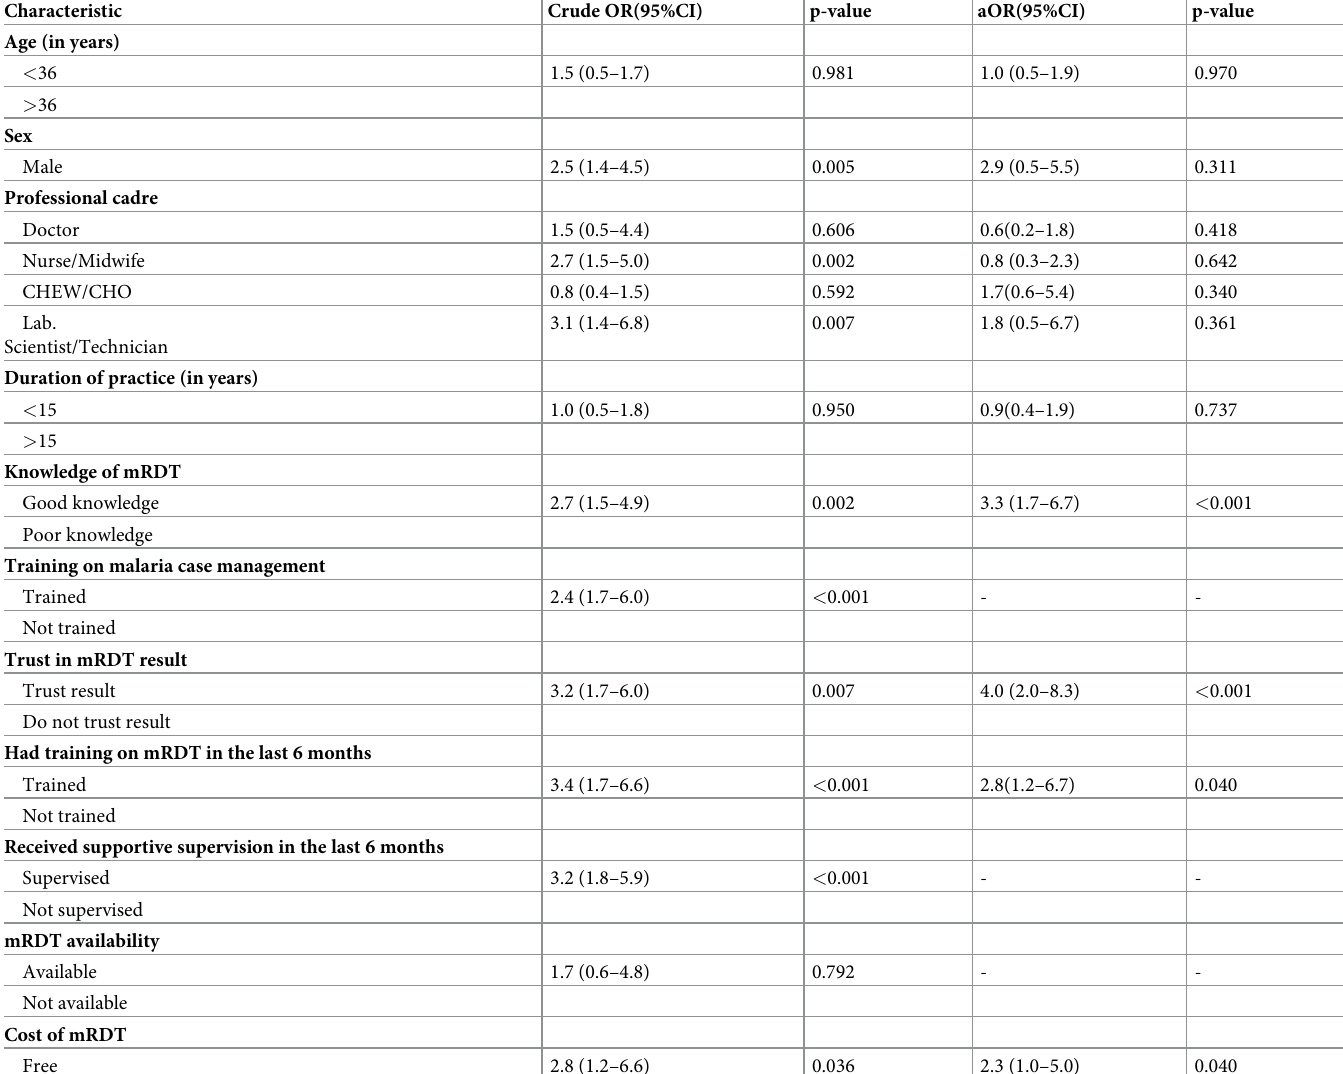
Table 4. Association between respondents’ factors, health system factors, and utilization of malaria rapid diagnostic test,